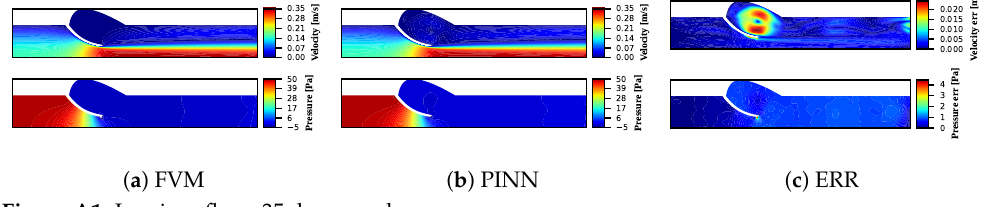
Figure A1. Laminar flow: 35 degree valve.